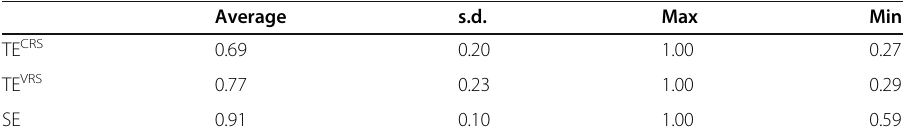
Table 3 Efficiency analysis results from